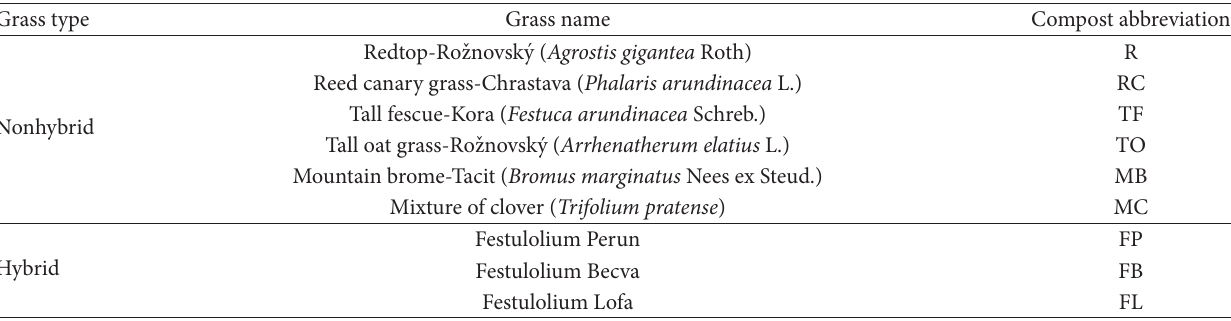
Table 1: Names and abbreviations of composts.